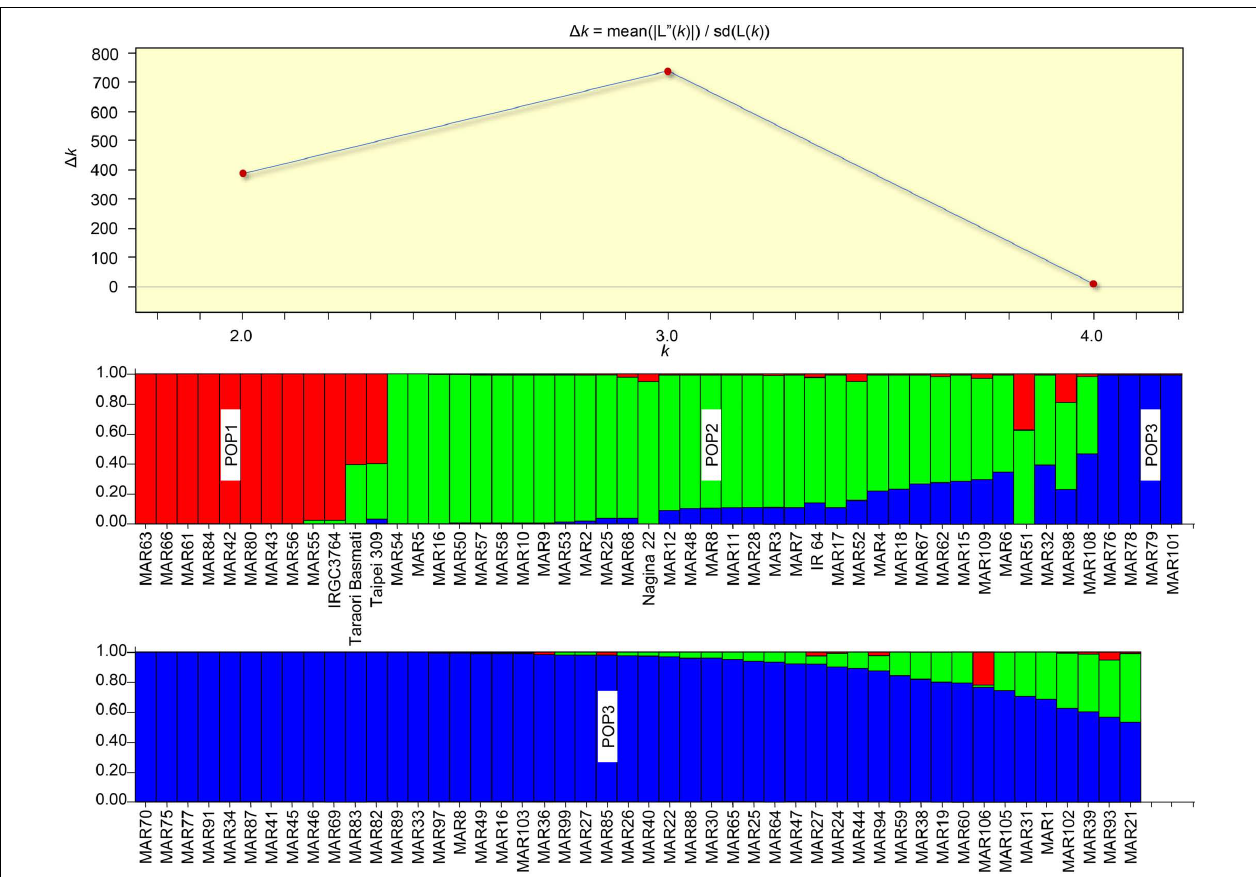
FIGURE 7 | Population structure of aromatic rice germplasm from Manipur. Three subpopulations were resolved by the highest (cid:49) K value (above). Among the subpopulations, POP1 showed more distinctness from other two. POP1 also was the group that did not have genetic admixing. POP2 and POP3 shared a large set of